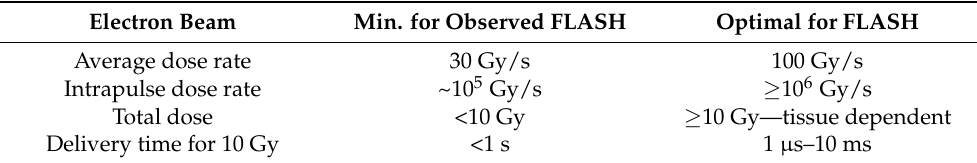
Table 1. Preclinical electron FLASH properties relevant to a clinical application of